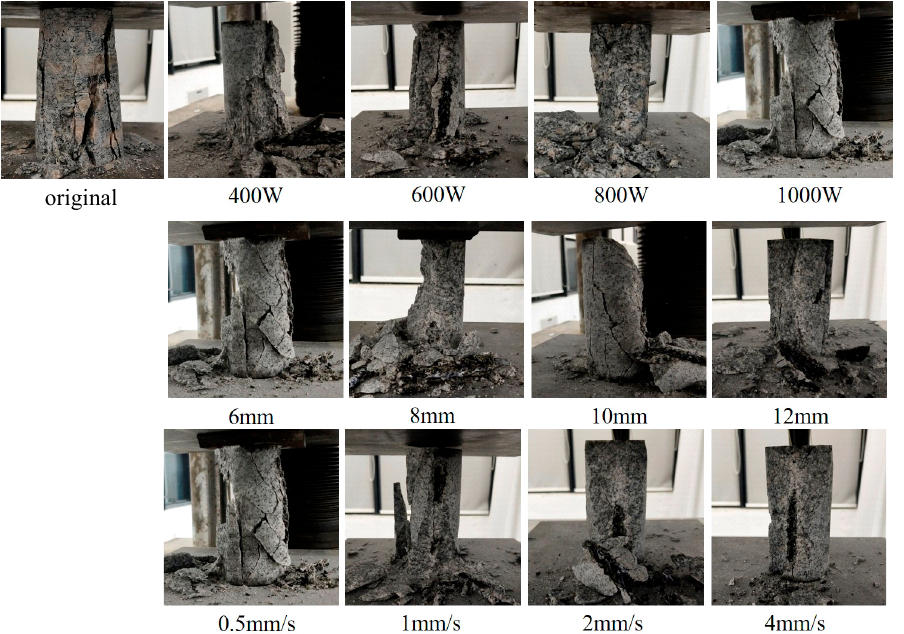
Figure 4. Images of granite with different irradiation parameters under uniaxial compression.